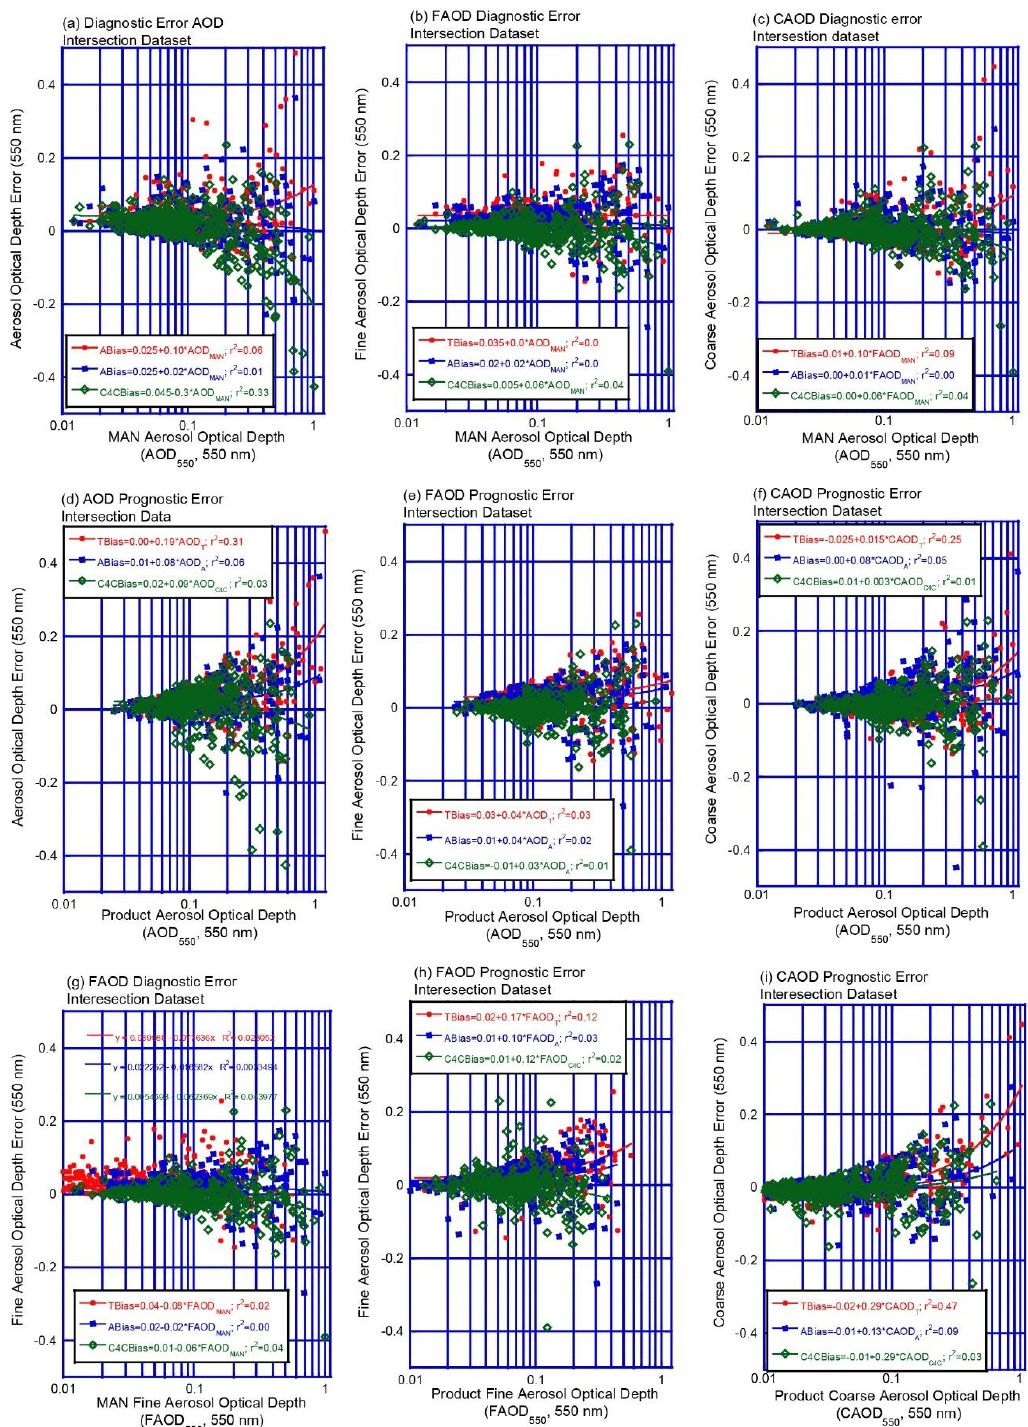
Figure 9. Comparisons of diagnostic and prognostic error for total, fine and coarse AOD. Error is taken as the difference between MAN minus Terra or Aqua MODIS retrievals and the ICAP C4C. Diagnostic error is taken as a function of MAN-derived AOD 550 and η 550 . ( a – c ) Diagnostic error against MAN AOD 550 for AOD 550 , FAOD 550 , and CAOD 550 , respectively. ( d – f ), prognostic error for AOD 550 , FAOD 550 , and CAOD 550 , respectively, against each products AOD values. ( g ) FAOD 550 diagnostic error against MAN FAOD 550 . ( h , i ) FAOD 550 and CAOD 550 prognostic error against each product’s FAOD 550 and CAOD 550 , respectively.